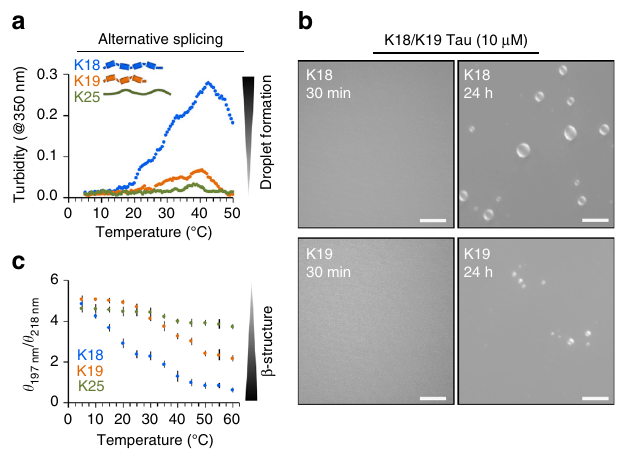
Fig. 3 Alternative RNA splicing in fl uences liquid demixing of the microtubule-binding domain of Tau. a Temperature-dependent changes in turbidity (at 350 nm) of solutions containing K19 (repeat region of 3R-Tau; orange ) and K18 (repeat region of 4R-Tau; blue ). Both samples contained 100 μ M protein in 50 mM sodium phosphate, pH 8.8 with 0.5 mM TCEP. Because of the presence of TCEP in the samples, C291/C322 (K18) and C322 (K19) were not oxidized, i.e., no intermolecular or intramolecular disul fi de bonds were formed, which would differentially in fl uence aggregation of 3R-Tau and 4R-Tau 46 . The N-terminal half of Tau called projection region (K25; green ; same sample conditions), which does not contain repeat sequences, did show at best very small changes in turbidity. b Liquid droplets observed for solutions of 10 μ M K18 and 10 μ M K19 — both incubated at 37 °C — by DIC microscopy. Scale bars correspond to 10 μ m.